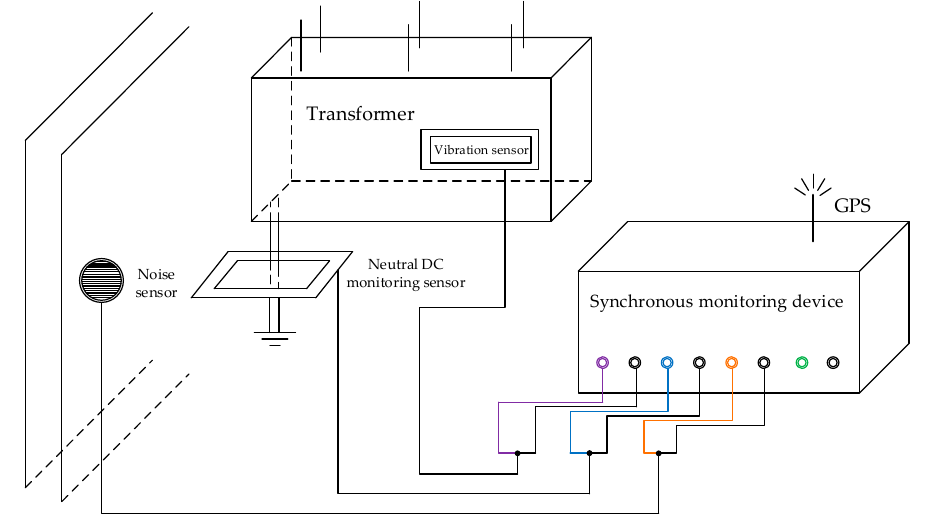
Figure 1. The composition and connection mode of the monitoring system.